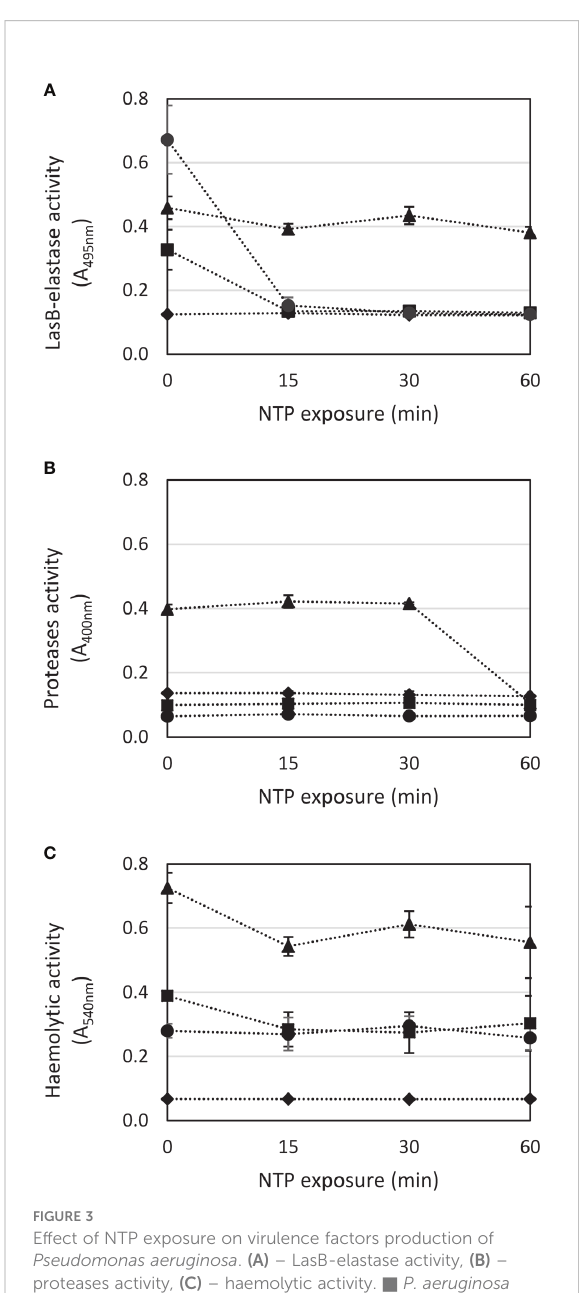
FIGURE 3 Effect of NTP exposure on virulence factors production of Pseudomonas aeruginosa . (A) – LasB-elastase activity, (B) – proteases activity, (C) – haemolytic activity. ■ P. aeruginosa ATCC 10145; ▲ P. aeruginosa ATCC 15442; ♦ P. aeruginosa DBM 3081; ⚫ P. aeruginosa DBM